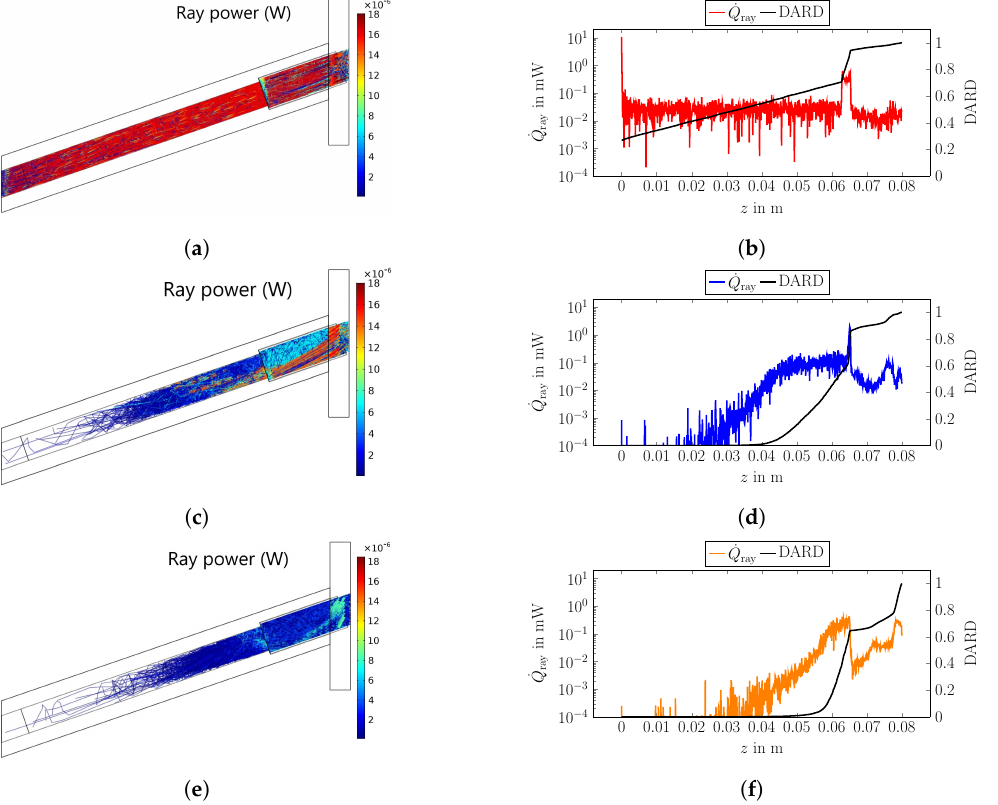
Figure 10. Ray power, total boundary heat flow ( ˙ Q ray ) and dimensionless accumulated radiation distribution (DARD) within the LCE for the angles of incidence of 19°, 35° and 60°. ( a ) Ray power within the LCE for an angle of incidence of 19°. ( b ) Total boundary heat flow and dimensionless accumulated radiation distribution for an angle of incidence of 19°. ( c ) Ray power within the LCE for an angle of incidence of 35°. ( d ) Total boundary heat flow and dimensionless accumulated radiation distribution for an angle of incidence of 35°. ( e ) Ray power within the LCE for an angle of incidence of 60°. ( f ) Total boundary heat flow and dimensionless accumulated radiation distribution for an angle of incidence of